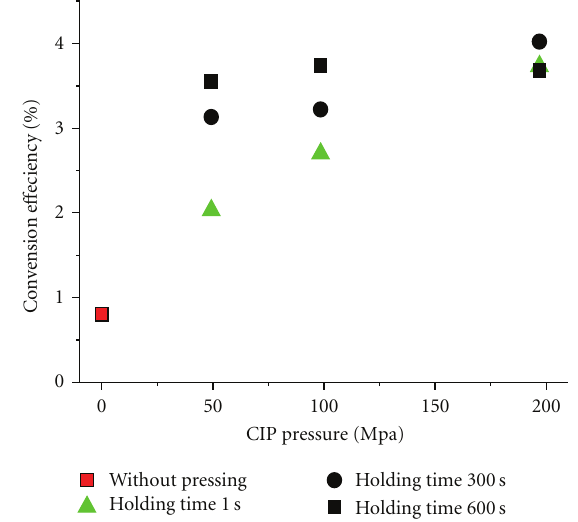
Figure 2: PCE of DSCs after the CIP process with pressure of 200 MPa, 100MPa and 50MPa and holding time of 1s, 300 s, and 600 s, respectively. The PCE of the sample without CIP was